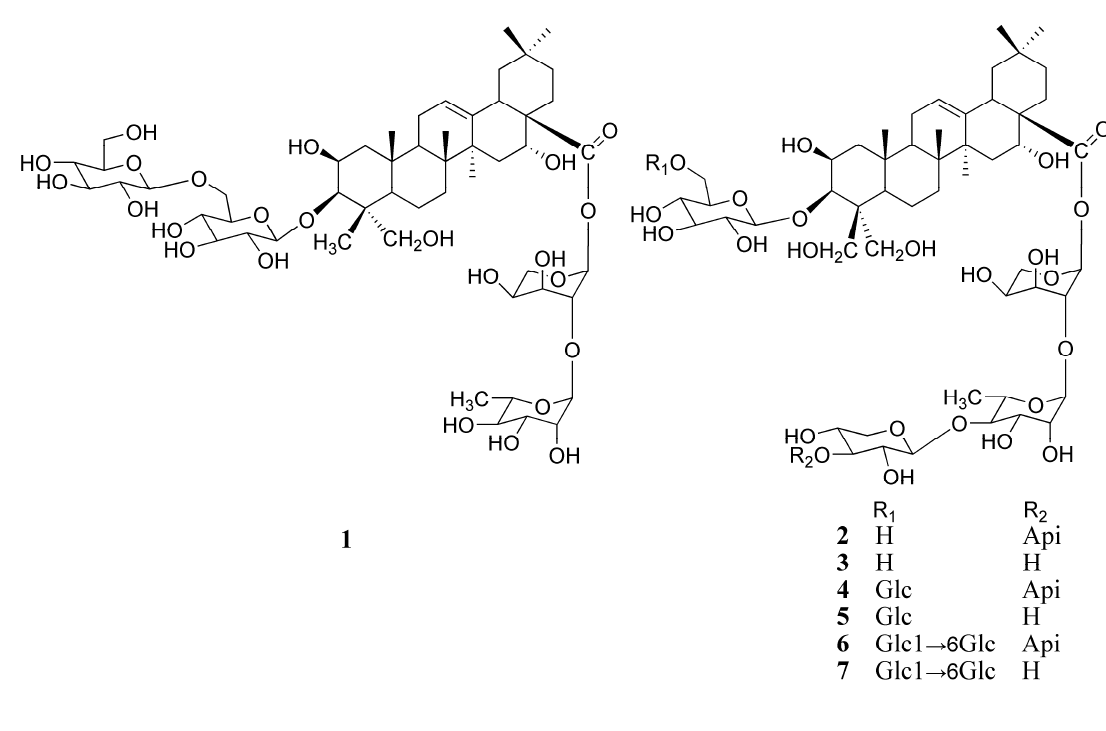
Figure 1 . Chemical structures of compounds 1-7